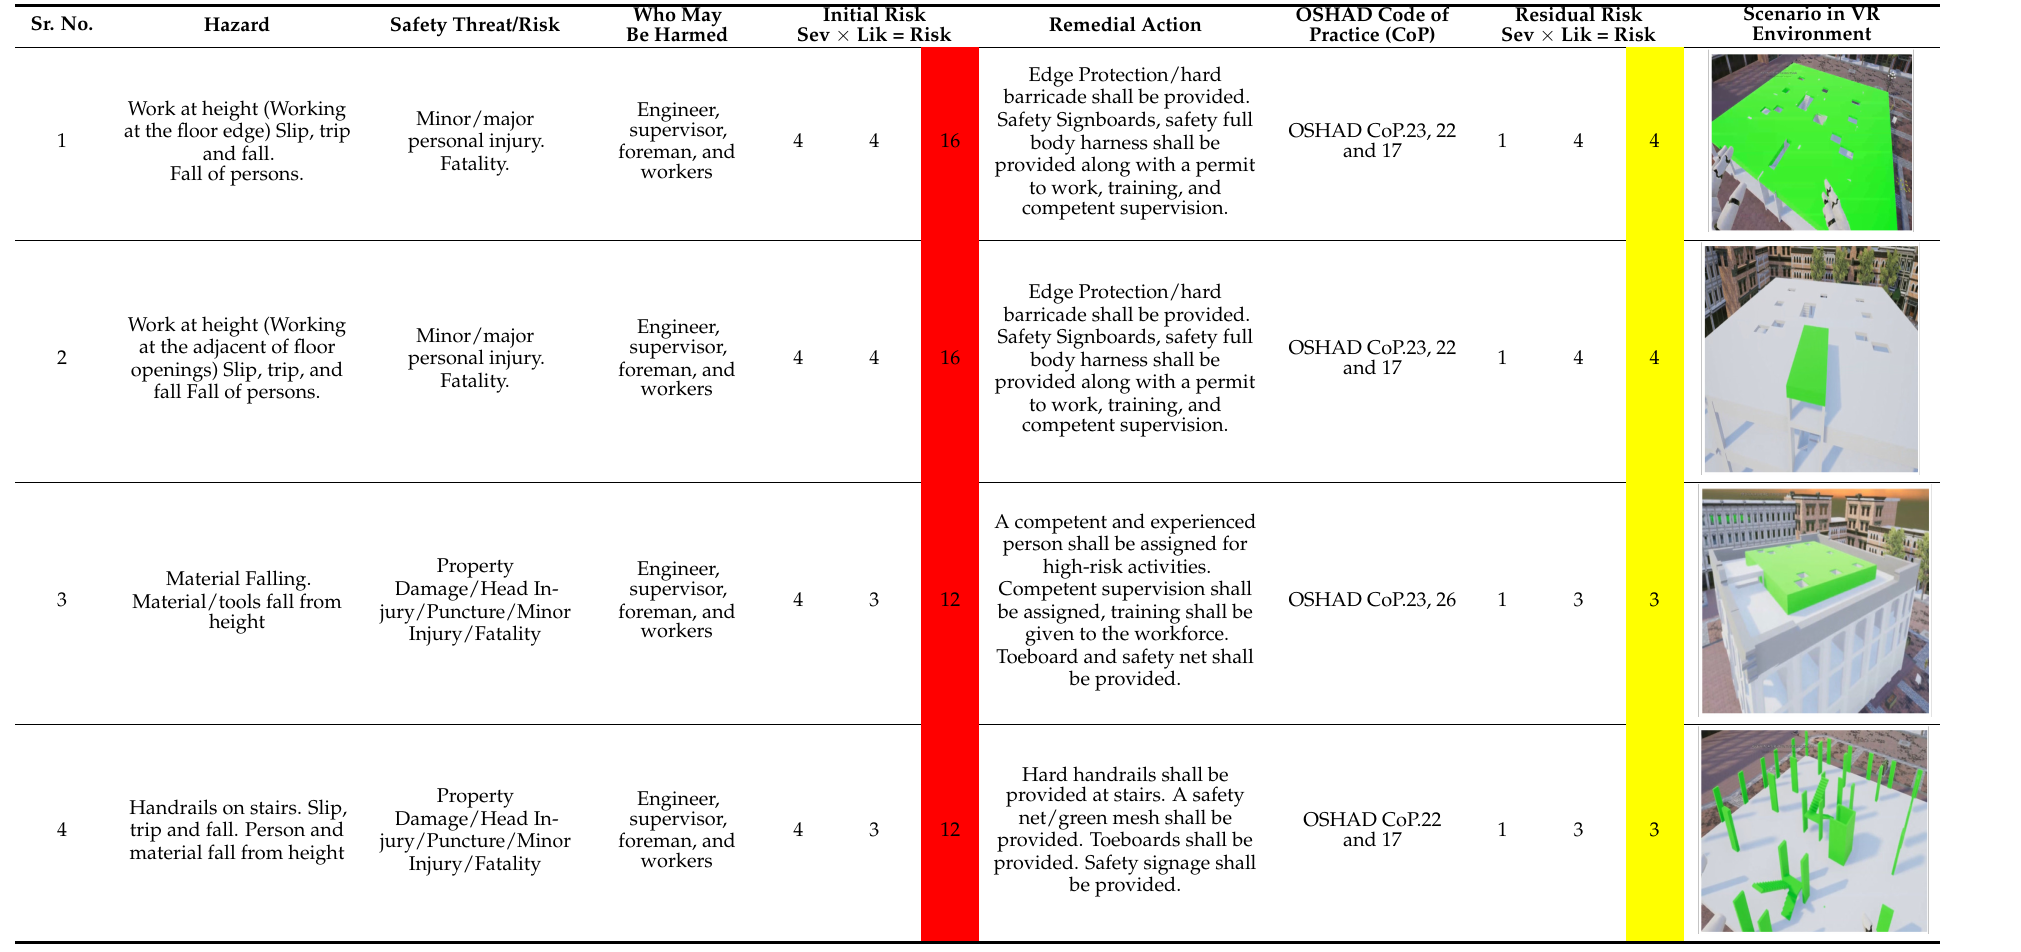
Table 2. NCEMA risk assessment matrix for likelihood and severity for safety risk